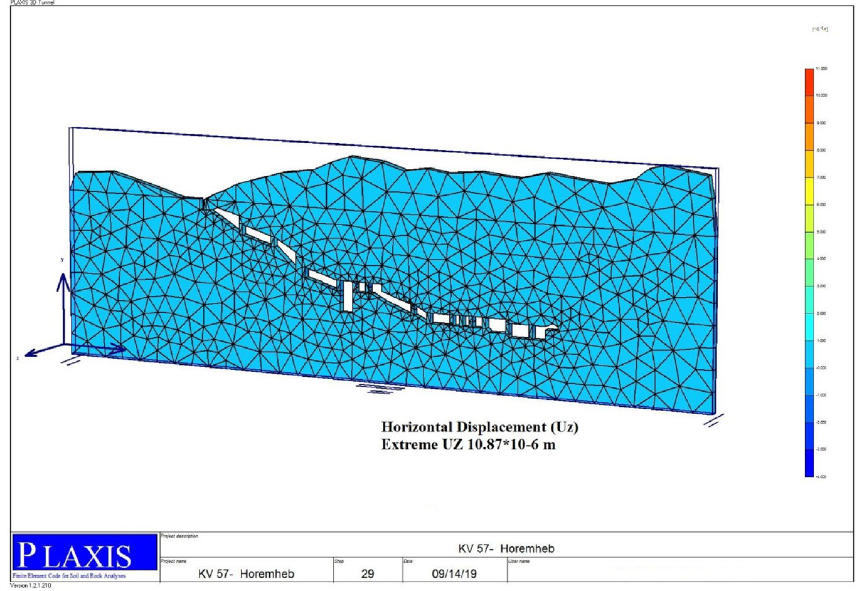
Fig. 6. Horizontal displacement Uz, the extreme value is 10.87